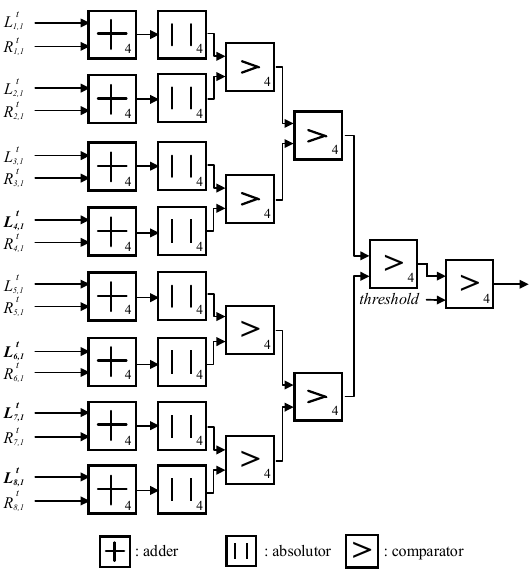
Figure 3. Hardware architecture of threshold-based early termination method [15] of (8, 4) polar.